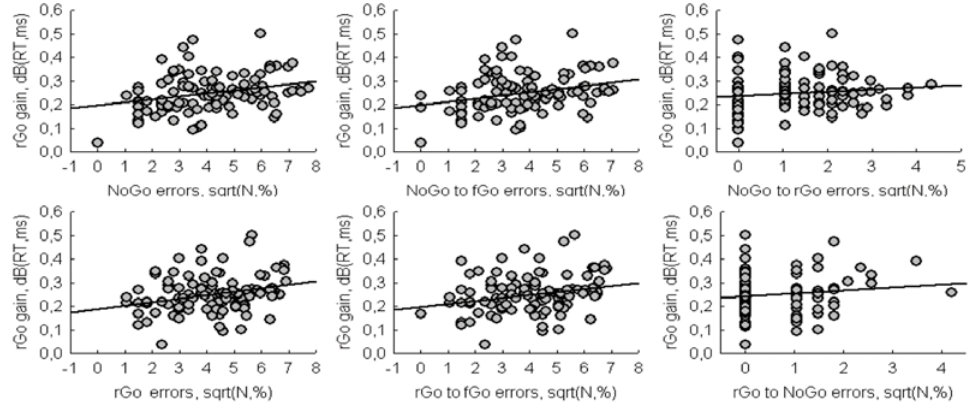
Figure 3. Scatterplots of correlations between the number of errors for rare Go and NoGo stimuli and RT gain for rare Go stimuli.